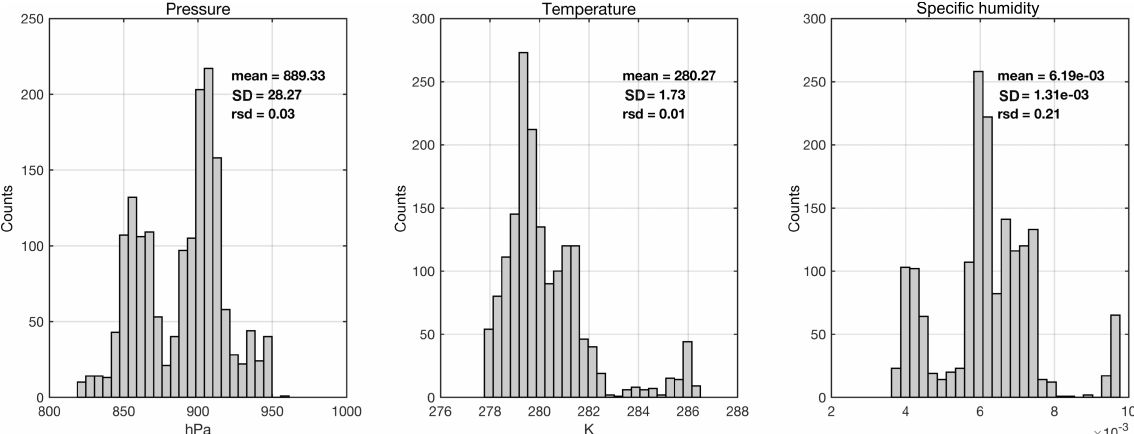
Figure 3. Histograms of the meteorological data for the aggregated data set. Table 3. ACI N (Eq. 3) together with Pearson product–moment correlation coefficient, r , calculated between ln( N d ) and ln(ATB) calculated for the aggregated data set. Data are divided in to bins of LWP. ACI N is calculated for the whole data set and only for the updraught areas. The number of measurements in each bin ( n ) and the percentage of data available for the updraught only areas are also presented. Whole data set Only updraught LWP